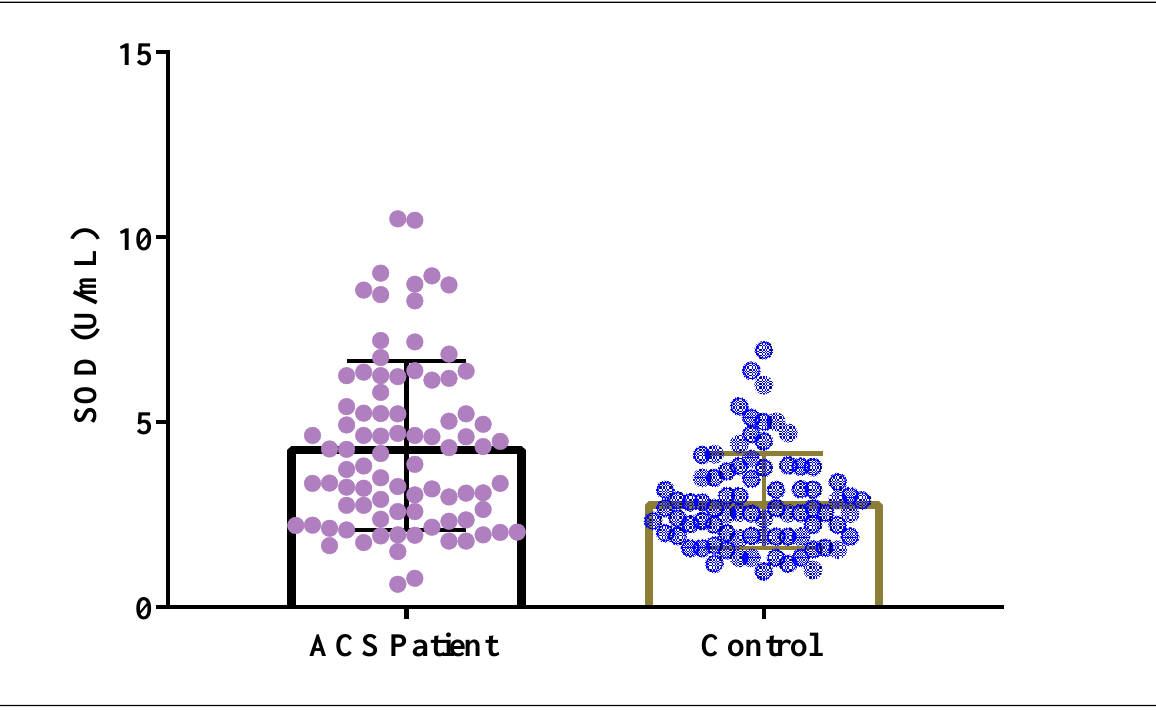
Figure 1: Comparison of serum Superoxide Dismutase (SOD) activity between the studied groups. The Acute Coronary Syndrome (ACS) patients had significantly higher SOD activity than the controls ( p < 0.01, Mann- Whitney U